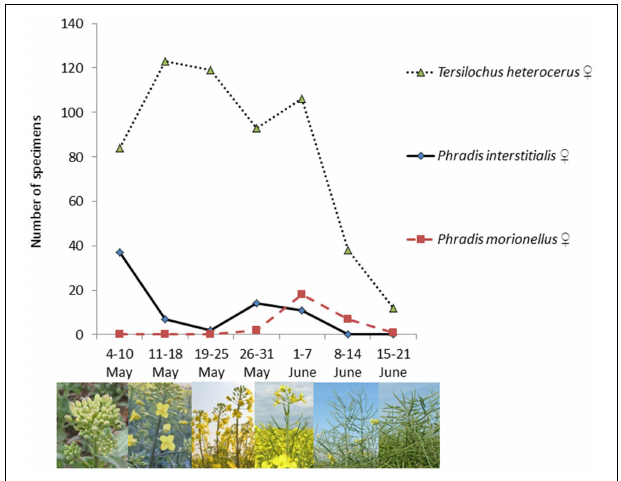
FIGURE 1 | Phenology of three pollen beetle parasitoid species collected by sweepnetting at Lönnstorp, southern Sweden, in 2011.